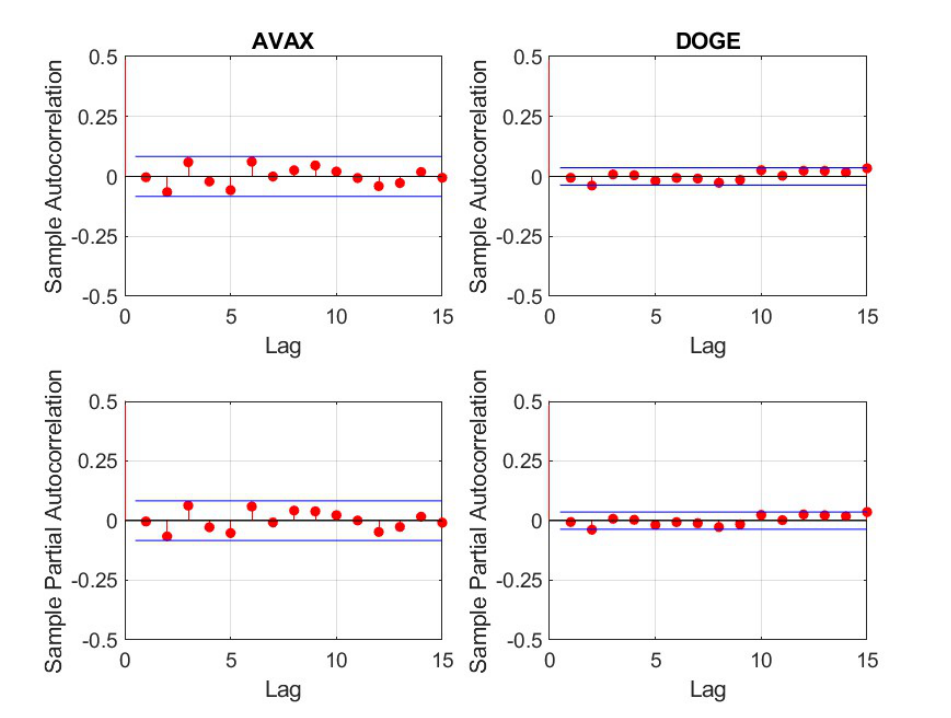
Figure A12. AVAX’s and DOGE’s residuals’ autocorrelation.